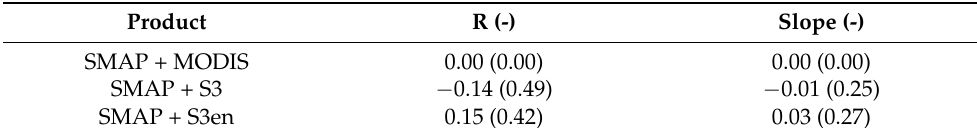
Table 3. Mean and standard deviation (values in parenthesis) of the daily correlation and slope coefficients between the 3 disaggregated products, and the in situ data for the field of Raimat. Product R (-) Slope (-) SMAP + MODIS resolution improves the fidelity with in situ measurements.